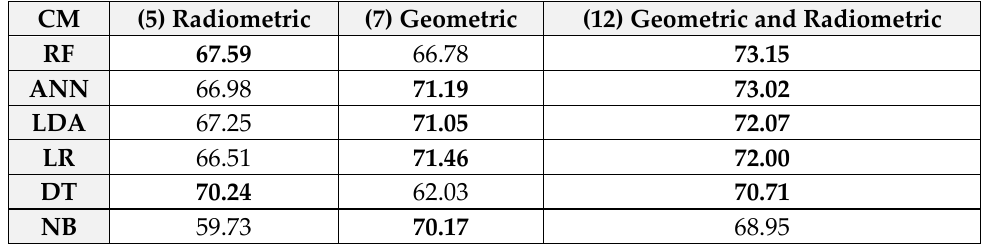
Table 4. Global classification accuracies for all tested ML algorithms, showing the performance of isolated and integrated radiometric and geometric features.